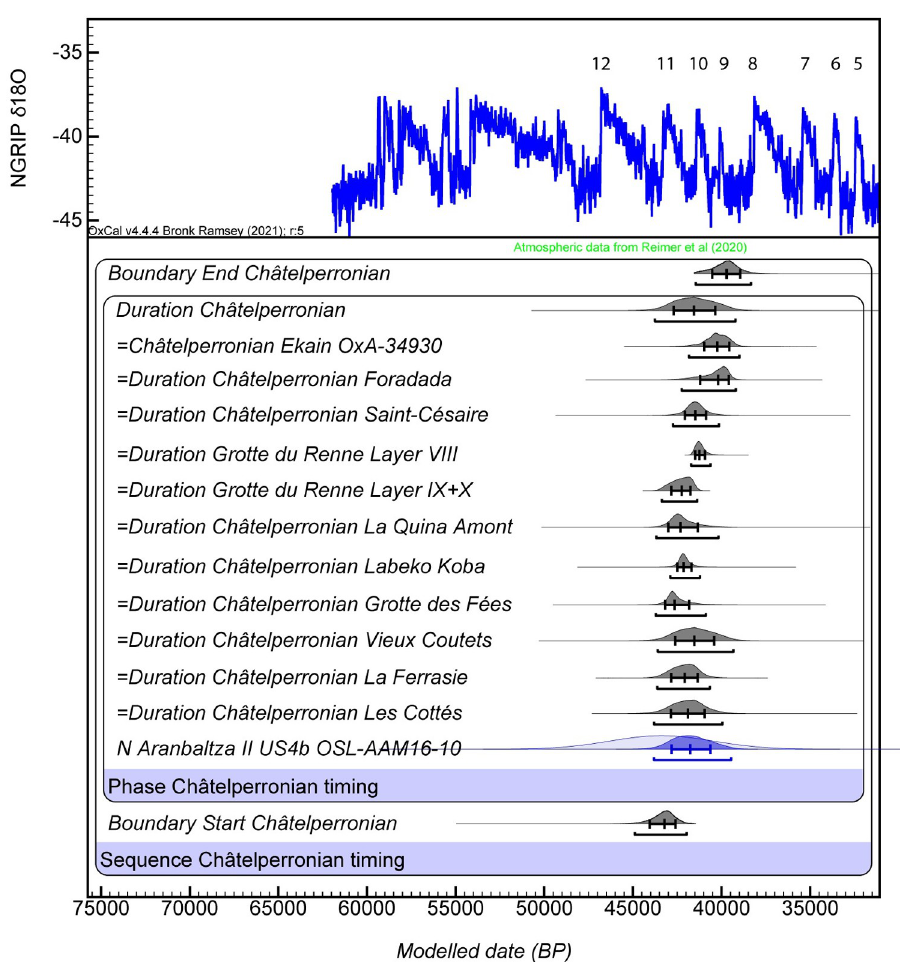
Fig 7. Bayesian modelling results for the timing of the Chaˆtelperronian culture in southwest Europe. The modelled durations of the Chaˆtelperronian culture (shown in grey) for sites that contain multiple dating results have been derived from site-specific Phase models using the Date command (see S39 Fig in S1 File for details). The site- specific modelled durations have been combined with the new OSL age for the Aranbaltza Chaˆtelperronian culture (unmodelled and modelled OSL age distributions shown as light blue and dark blue, respectively) as part of the regional Chaˆtelperronian Phase model shown here. The combined age range for the Chaˆtelperronian culture of southwest Europe (“Duration Chaˆtelperronian”) has been calculated from the modelled posterior probabilities of the start and end boundaries of this Phase model (also shown in grey) using the Date function. Bayesian modelling has been undertaken in OxCal v.4.4.4 [70], assuming each likelihood has a 5% prior probability of being an outlier within a general t-type outlier model [71]. The median ages and 1 σ uncertainty ranges are shown for the modelled probability distributions. The 95.4% ranges of the highest posterior probabilities are also indicated by the broader horizontal bars underneath the probability density functions. The modelled durations are compared against the NGRIP GICC05 δ 18O record, with interstadials (milder climatic periods) numbered